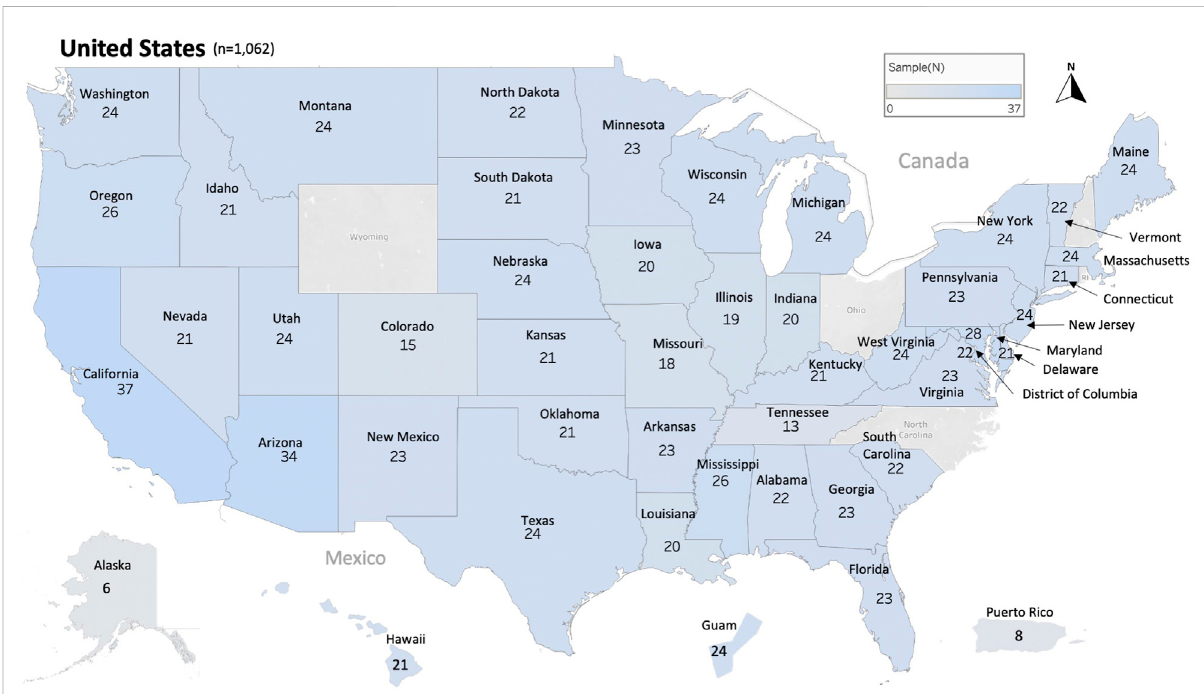
FIGURE 1 Distribution and number of honey bee samples originated from 45 states, the District of Columbia and two territories of the United States of America USA. Total number of samples nationwide is (n = 1,062). Each sample represents a distinct apiary composed of 8 colonies or